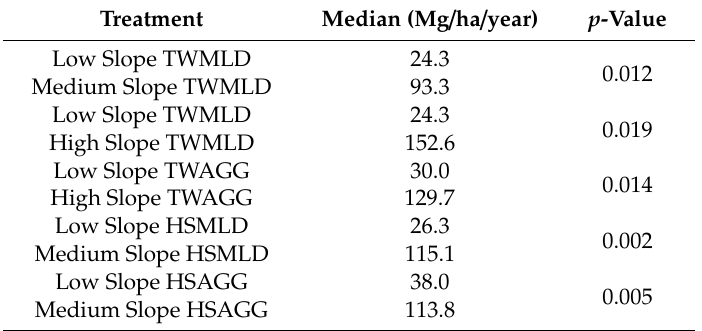
Table 4. Significant di ff erence ( α = 0.05) between slope classes and treatments for the median weighted average erosion rates.